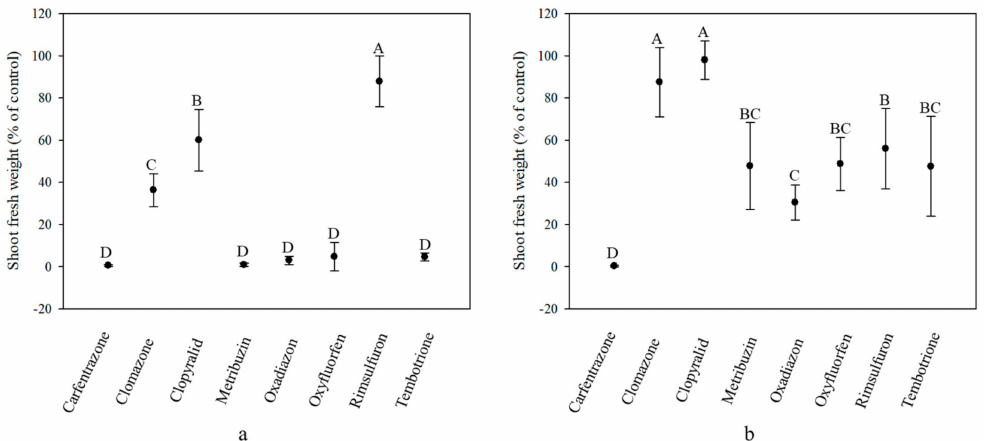
Figure 3. Shoot fresh weight (% of control) of Solanum rostratum plants from the Givat Yoav population treated with the recommended field rate of various herbicides at the 4–5 cm ( a ) and 8–9 cm ( b ) growth stages. Shoot fresh weight was recorded 21 days after herbicide application. Different uppercase letters indicate statistically significant differences among treatments, as determined by a Tukey–Kramer HSD test ( α =